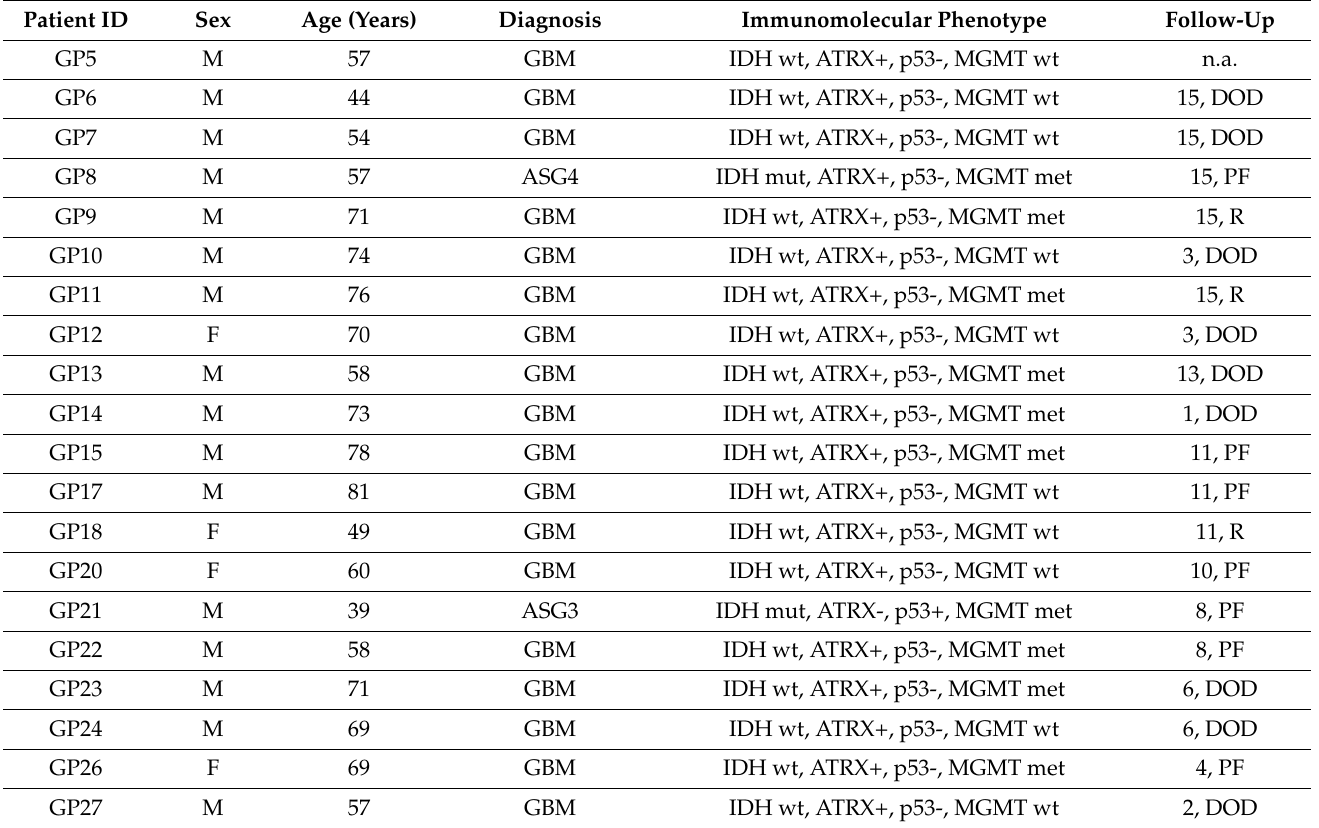
Table 1. Clinicopathological characteristics and immunomolecular phenotype of glioma patients (GP) enrolled in the study. M: male; F: female; GBM: glioblastoma IDH-wildtype; ASG4: astrocytoma IDH-mutant, grade 4; ASG3: astrocytoma IDH-mutant, grade 3; wt: wild-type; mut: mutated; +: <30% of positive cells; -: no staining; met: methylated; follow-up period expressed in months; DOD: patient dead of disease; R: relapsed patient, follow up ongoing; PF: progression free patient, follow up ongoing; n.a.: no information